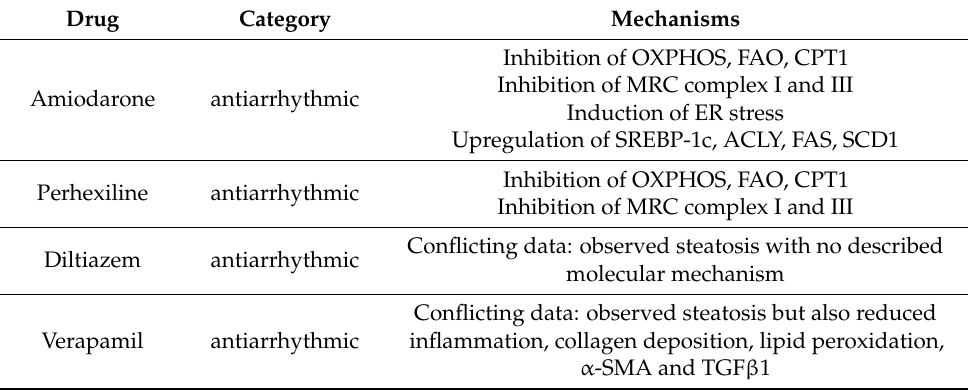
Table 1. List of the major drugs involved in steatosis onset and progression. They are classified according with their clinical use; their mechanisms of steatosis induction are also